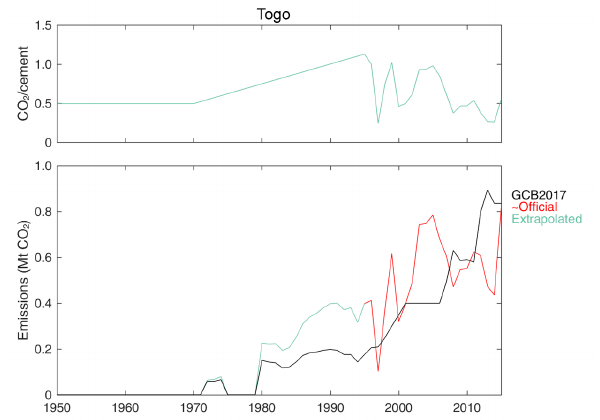
Figure C36. Revised cement emissions in Togo.